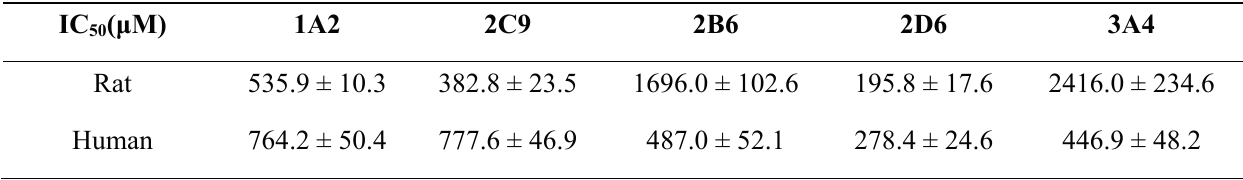
Table 1. Inhibitory potencies of TCAS on the activities of CYP450 enzymes in rat and human liver